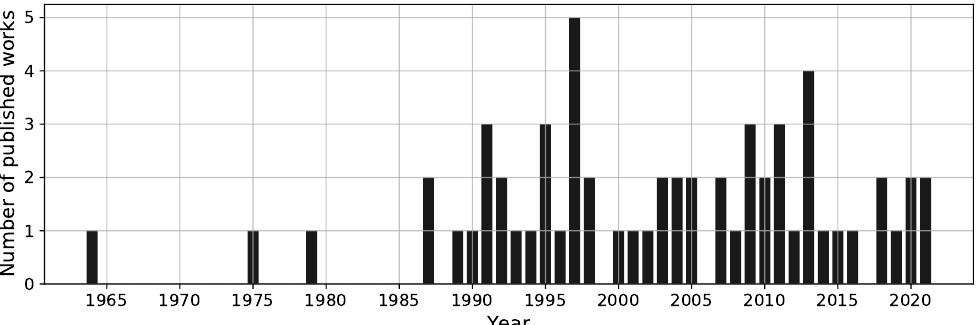
Figure 3. Number of published works as extracted from Google Scholar (last accessed 20 Octo- ber